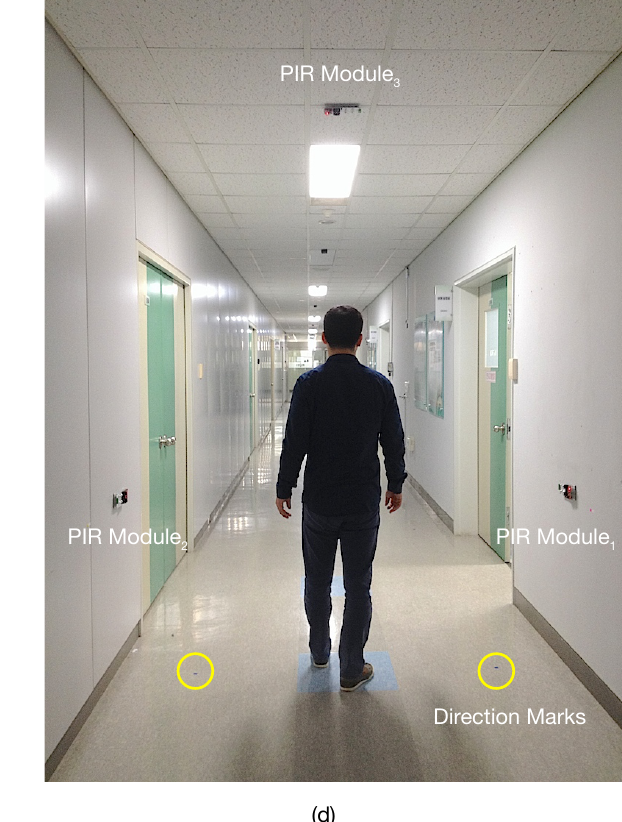
, T , T ) to three peaks 1 2 3